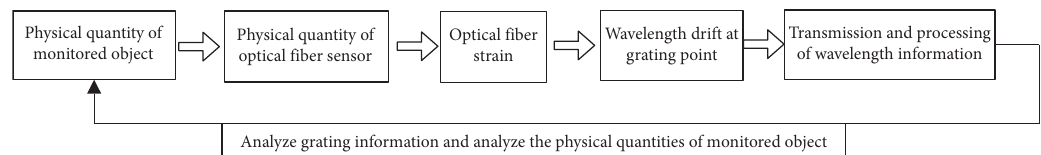
Figure 2: Fundamental of measuring external physical quantities using FBG sensing technology.